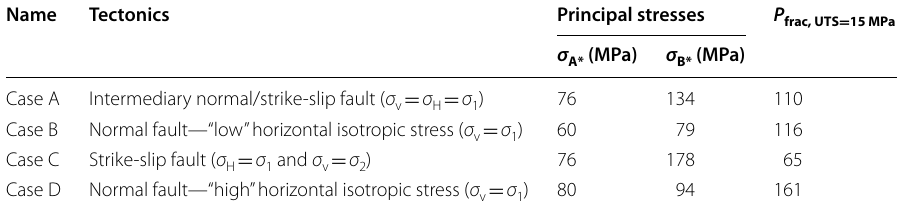
Following Eq. 14 in Appendix with (cid:31) T = 0 and UTS 15 MPa. Principal stresses in the cross section perpendicular to the = wellbore axis are obtained by diagonalization of the stress state ( σ ss , σ dd , τ sd ) mentioned in Table 1 and are thus slightly different from horizontal principal stresses